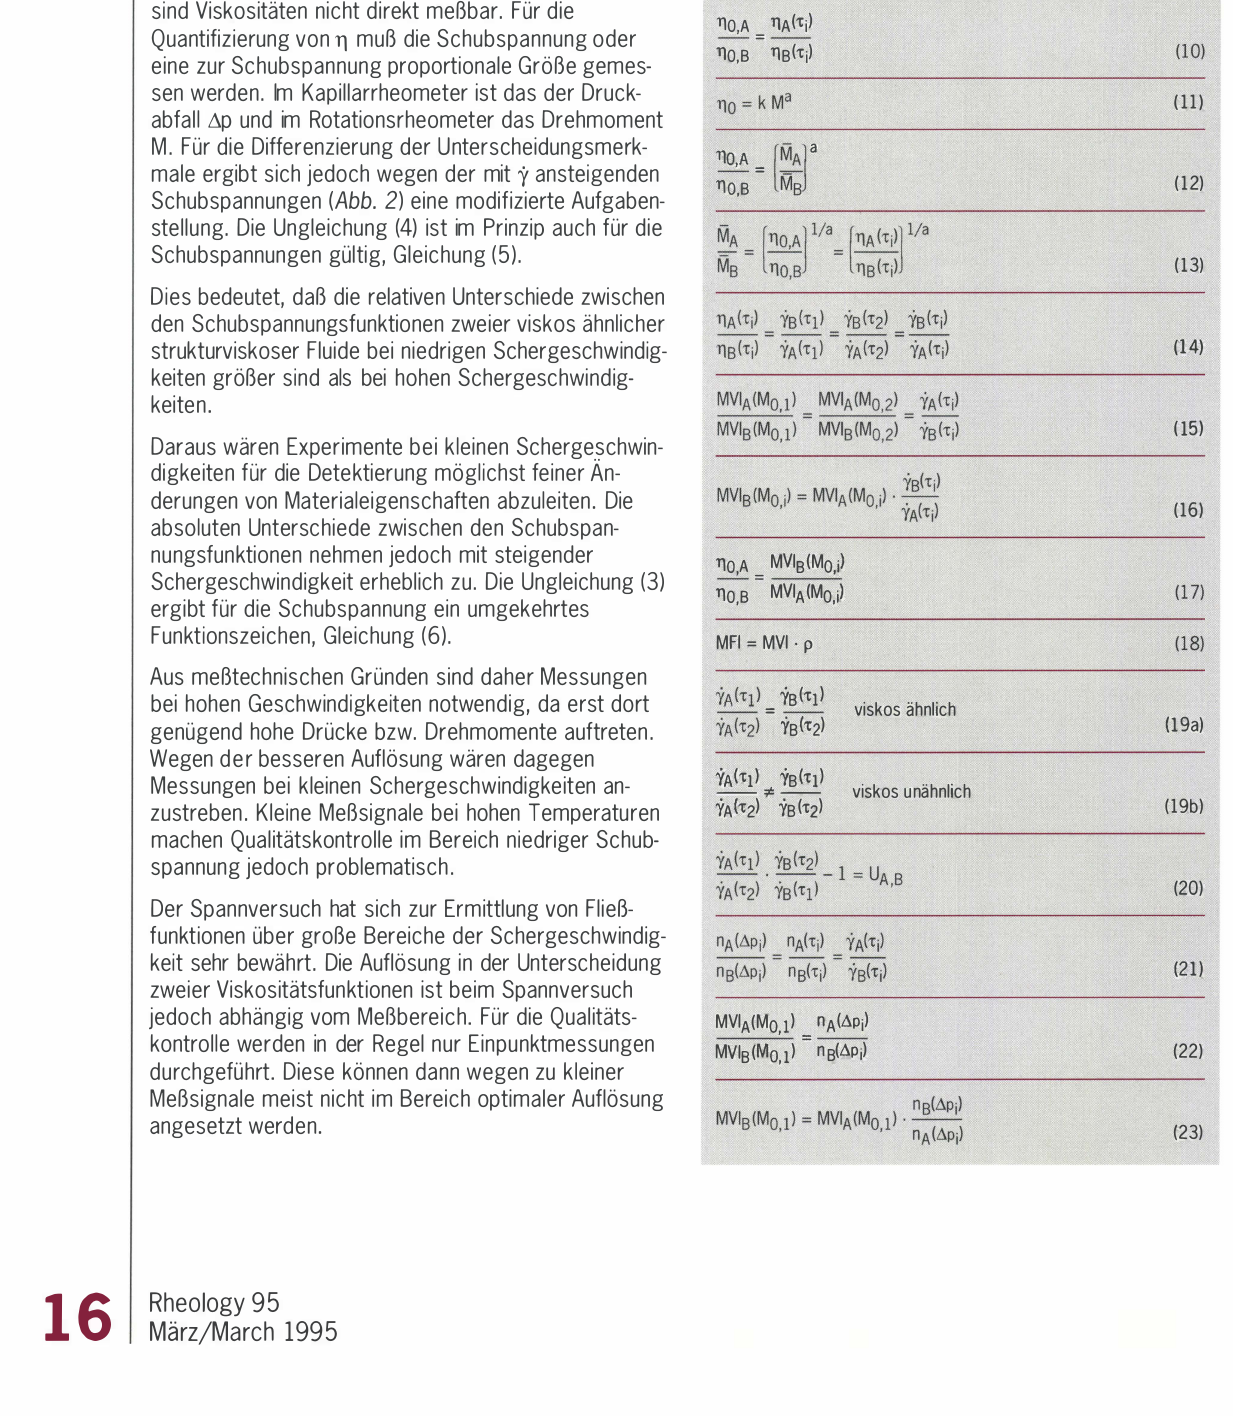
I der viskos funktionen � 1 1 iihnlichen Plexiglassorten BH, lN und 5N mit diskreten Werten der Schubspannung bei den Schergeschwindig­ keiten Y! und 12 Fig. 2: Shear stress functions �11 I of the viscoelastic similar Plexiglas types BH, lN and 5N, with discrete values of the shear stress at shear rates und 1 1